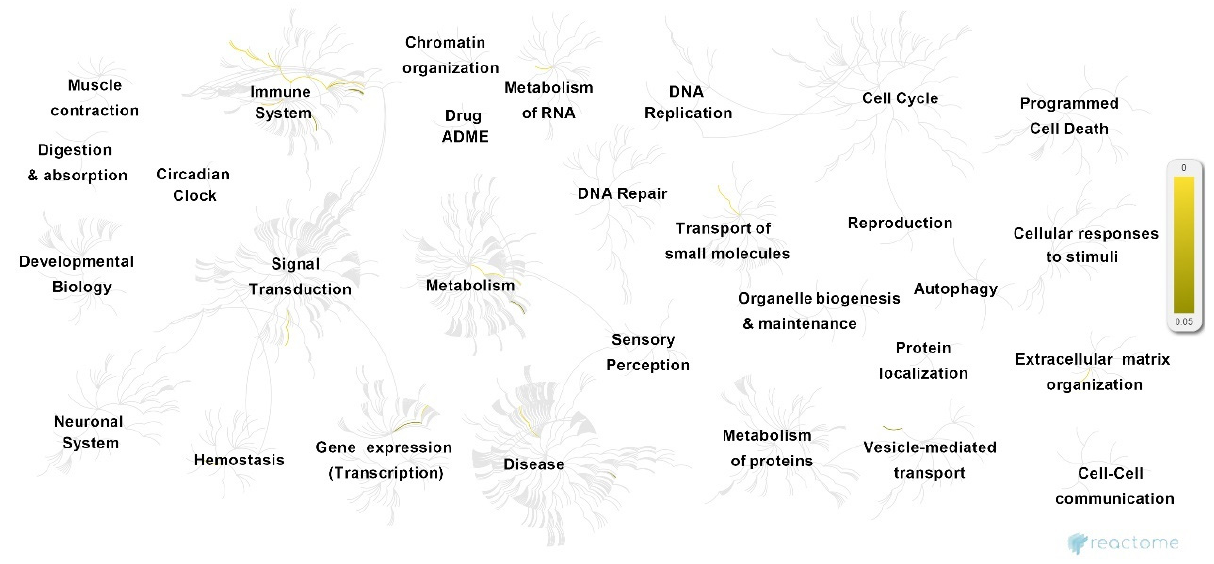
Figure 3. Overview of pathways associated with GTN genes, following Reactome analysis. Significantly enriched pathways ( p < 0.05) are highlighted in yellow.